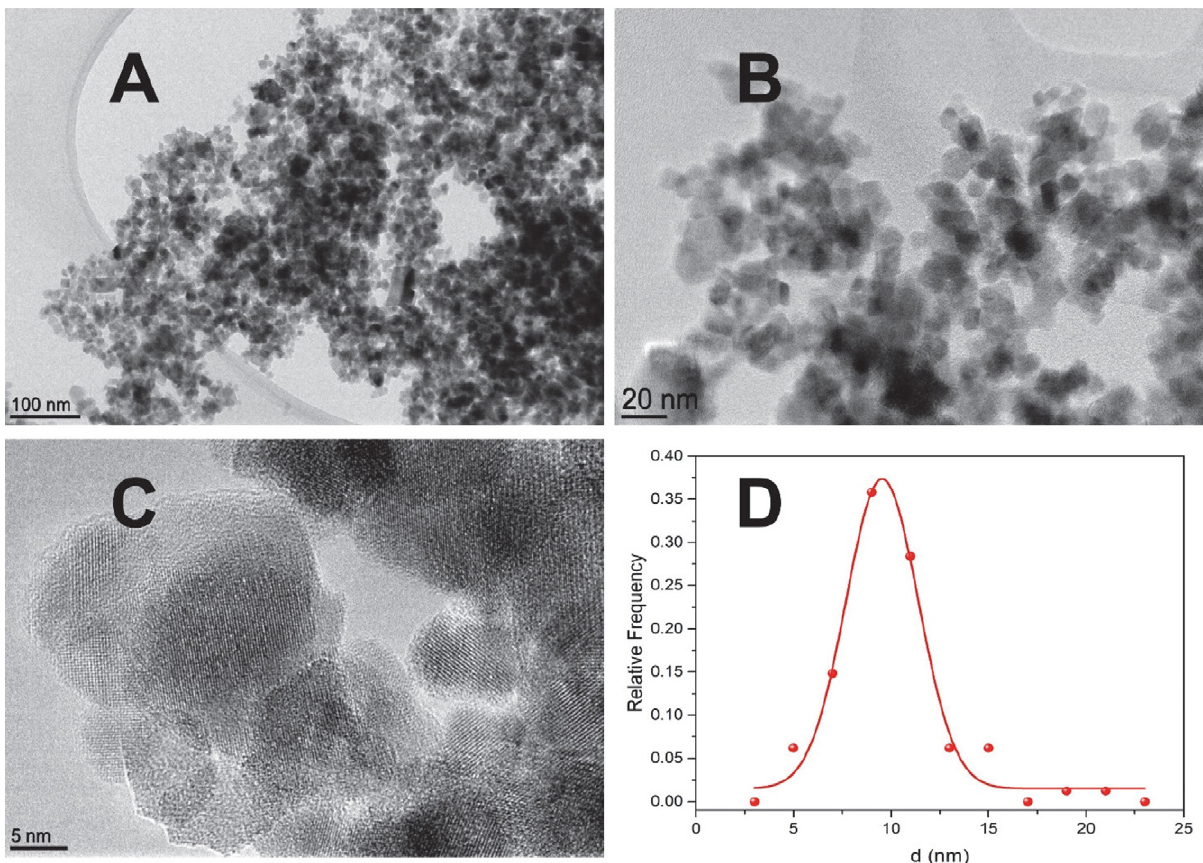
Figure 4: TEM images of γ-Fe 2 O 3 -NH 4 OH@SiO 2 (APTMS) with increasing magnification (A: scale bar 100 nm, B: 20 nm, C: 5 nm) and size distri- bution of MNPs